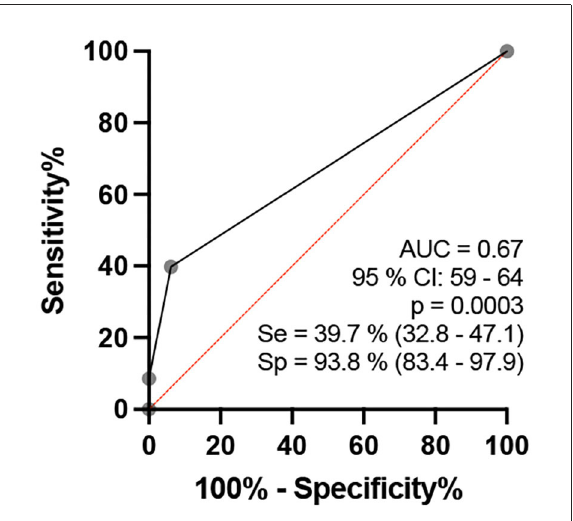
FIGURE9 ROC curve analysis of the percentage of altered nerves among the nerves assessed per individual in healthy and HD groups.